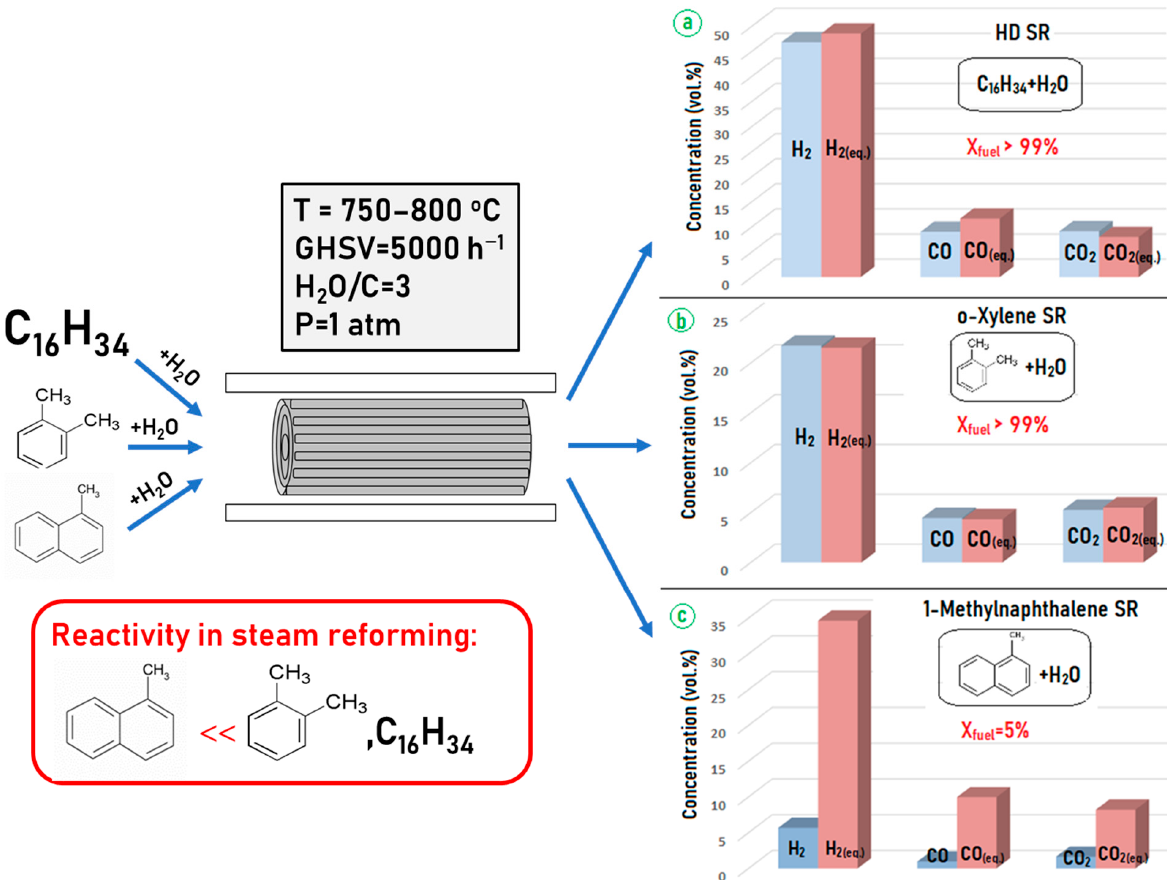
Figure 13. Steam reforming of HD ( a ), o-xylene ( b ) and 1-methylnaphthalene ( c ) over Rh60. Comparison of products concentrations with equilibrium values (red columns). Adapted from [97].